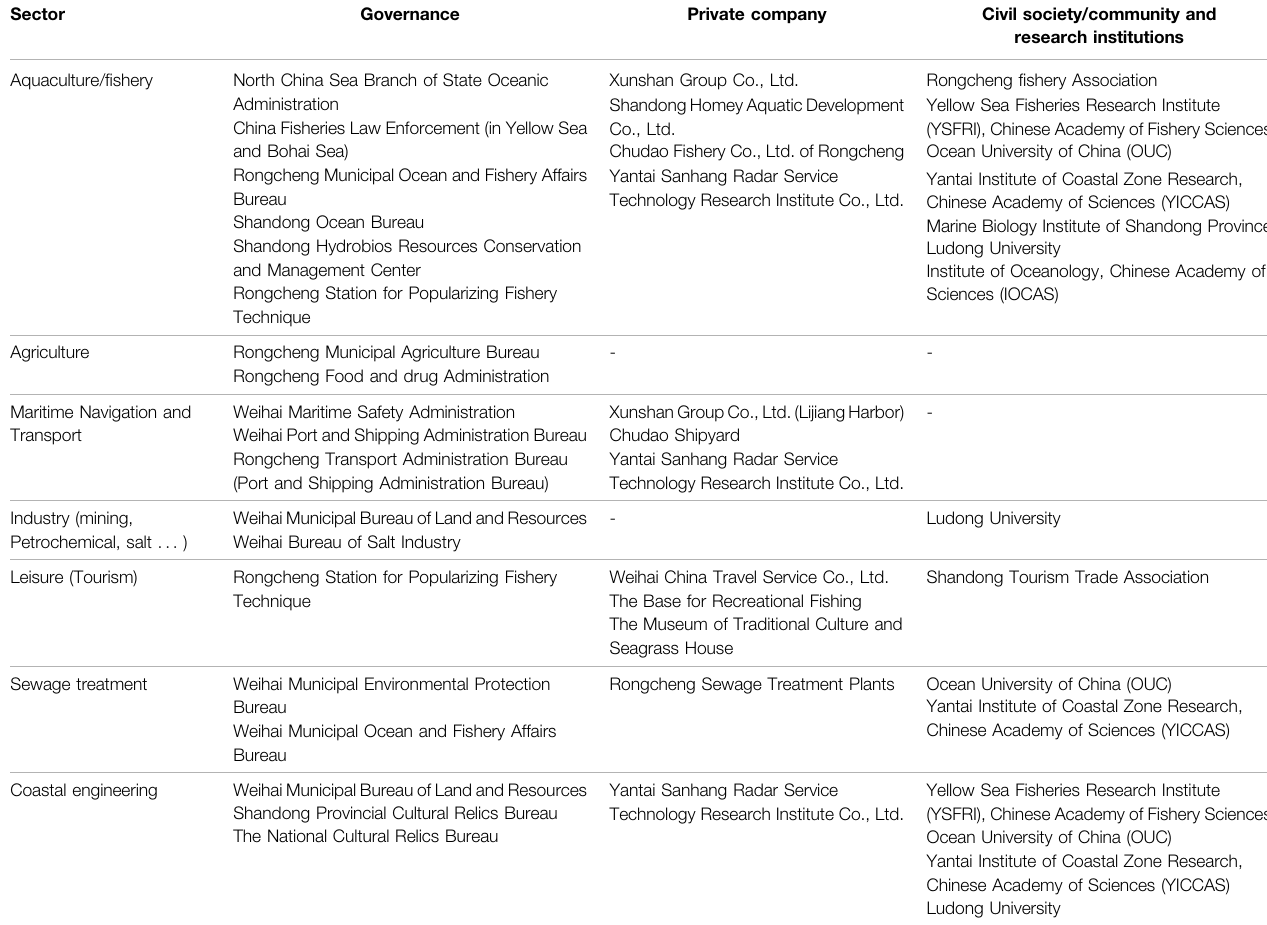
TABLE 1 | Stakeholders related to the Rongcheng City coastal